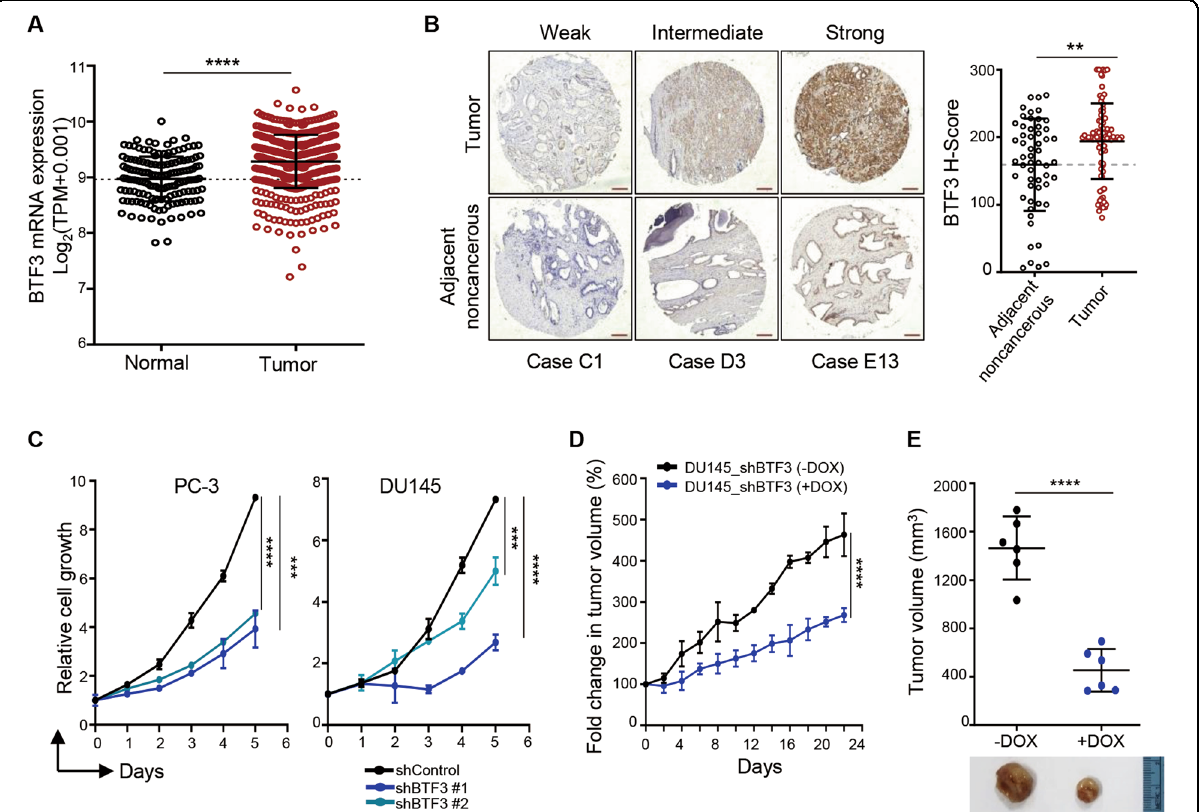
Fig. 1 BTF3 plays an oncogenic role in prostate cancer in vitro and in vivo. a BTF3 expression levels in prostate cancer and normal tissue. Transcriptome data of prostate tumors from TCGA and normal tissues from TCGA and GTEx samples were obtained from the UCSC Xena (https:// xena.ucsc.edu). The gene expression is reported as log 2 (Transcripts per million (TPM) + 0.001). Each dot represents an individual sample ( n = 496 for prostate tumor; n = 149 for normal tissue. The black lines in each group indicate the mean ± S.D. **** p < 0.0001 (Mann – Whitney test). b Immunohistochemistry staining of tissue microarray from prostate tumors and adjacent noncancerous tissues using anti-BTF3 antibody. Representative images of BTF3 stained tumor and their corresponding noncancerous tissue sections are shown in weak, Intermediate, and strong staining, respectively. The scatter plot graph showing a statistical analysis of BTF3 expression (H score) in tumor and adjacent noncancerous tissues. Data are shown as mean ± S.D.; n = 82 for tumors and n = 55 for adjacent noncancerous tissues. Scale bar, 25 μ m. ** p < 0.01 (Mann-Whitney test). c Relative cell growth of PC-3 and DU145 prostate cancer cells with or without BTF3-knockdown was measured by crystal violet assay. Data are shown as mean ± S.D. for three independent experiments. *** p < 0.001, **** p < 0.0001 (Student ’ s t -test). d , e DU145-Tet-On-shBTF3 xenografted mice were treated with or without doxycycline. The graph shows the fold change in tumor volume, with respect to the initial treatment at day 0 ( d ). The tumor volume and representative images of dissected tumors at the endpoint of treatment are shown ( e ). Dox, Doxycycline (2 mg/ml in drinking wat e r). The data are shown as mean ± S.E.M ( n = 6 for each group). **** p < 0.0001 (Student ’ s t